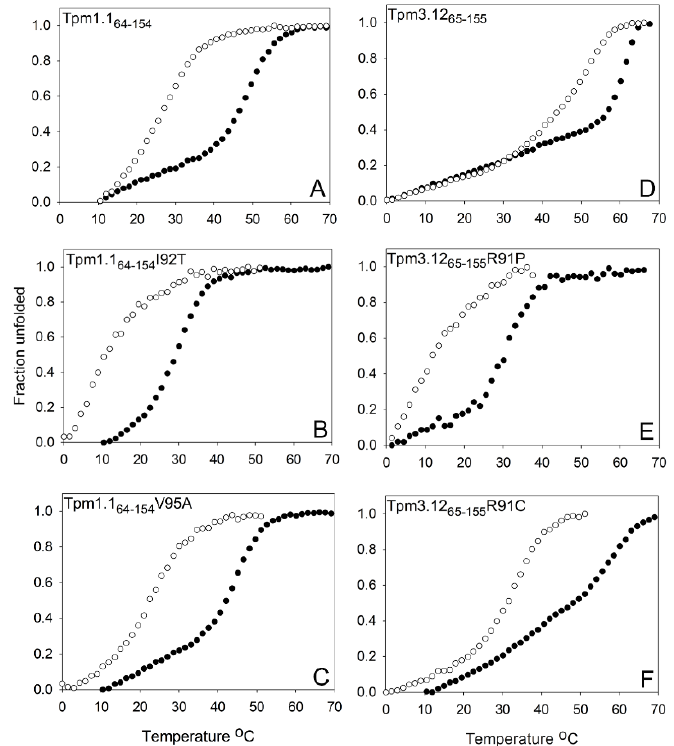
Figure 3. Effect of mutations on the thermal stability of Tpm1.1 64–154 and Tpm3.12 65–155 . Melting of Tpm1.1 64–154 ( A ), Tpm3.12 65–155 ( D ), and their respective mutants ( B , C , E , F ) were measured at 222 nm in 100 mM NaCl, 10 mM Na-Phosphate, pH 7.0, with ( ○ ) and without ( ● ) 0.5 mM DTT. Fraction unfolded is the ratio of unfolded to folded peptides (see Materials and Methods). Table 1. Effect of the mutations on melting temperature (T m ) of Tpm1.1 64–154 and Tpm3.12 65–155 under non-reducing and reducing conditions. Melting temperatures were determined from melting curves measured in 10 mM Na-phosphate, 100 mM NaCl, pH 7.0, under reducing (0.5 mM DTT) and non-reducing (no DTT) conditions. ND: not determined. The numbers are mean values from three measurements ±